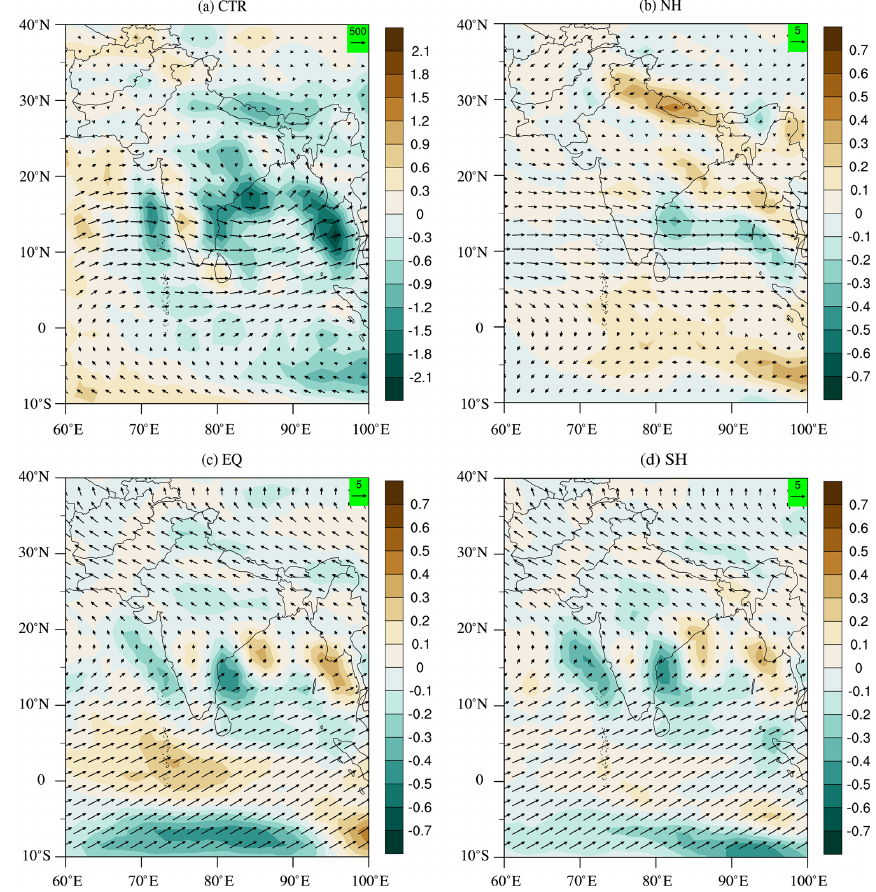
Figure 8. JJA mean vertically integrated moisture transport (IVT, vector, kgm − 1 s − 1 ) and its divergence (IVTD, shaded, kgm − 2 s − 1 ) for the control runs without any volcanic eruption (a) , and their anomalies after the NH (b) , EQ (c) and SH (d) volcanic eruptions in